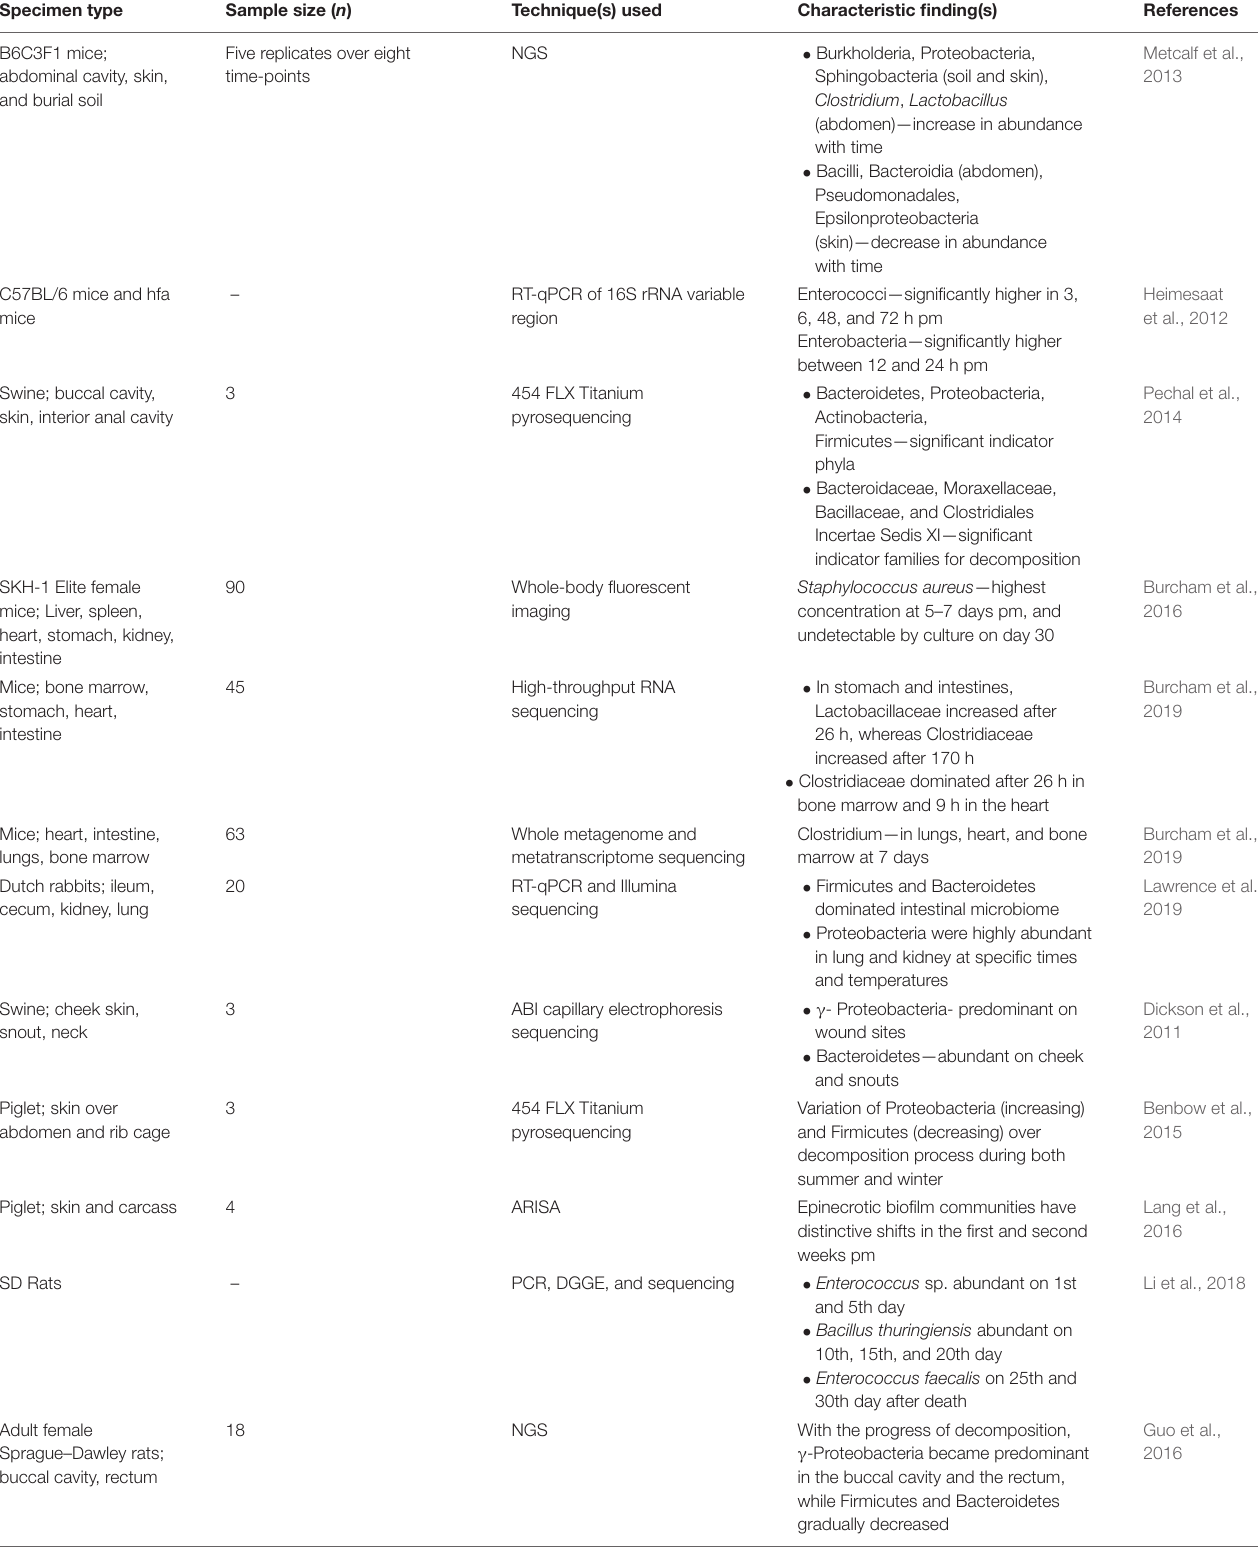
TABLE 3 | Mammalian model systems for estimation of time since death using microbiome